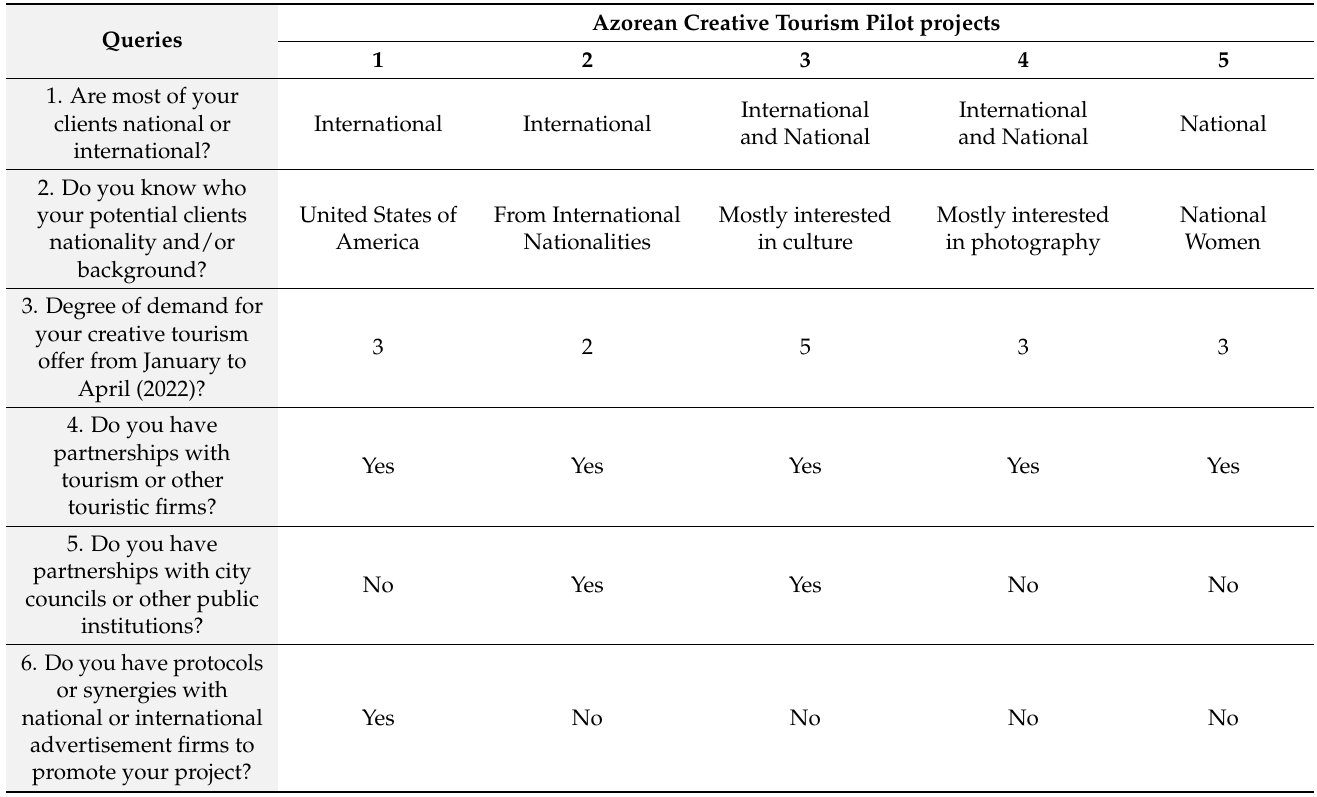
Table 1. Outline of the item selection queries about the business plan models of the pilot projects.